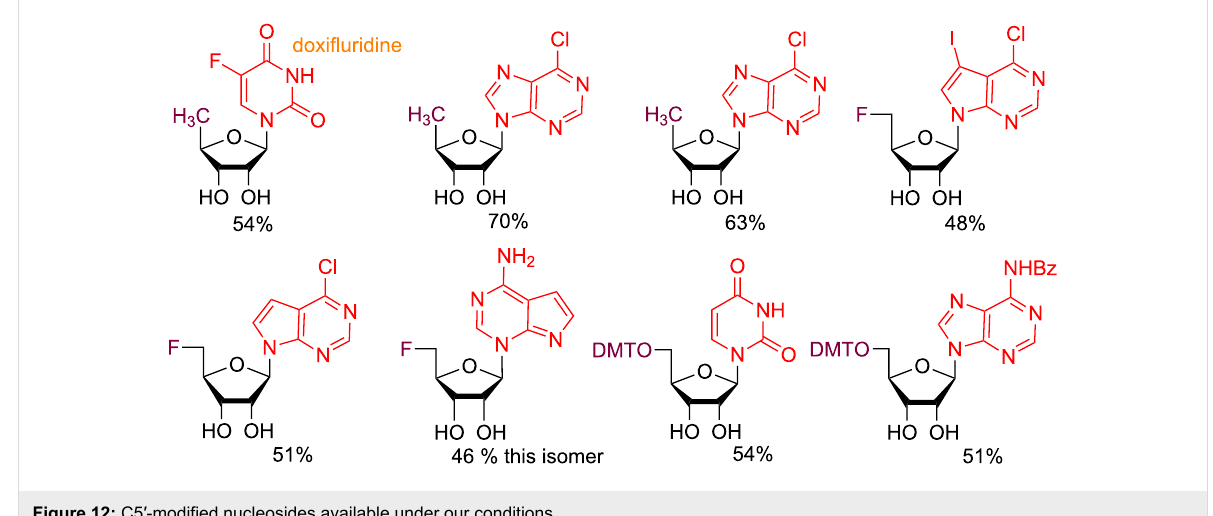
Figure 12: C5 ′ -modified nucleosides available under our conditions.